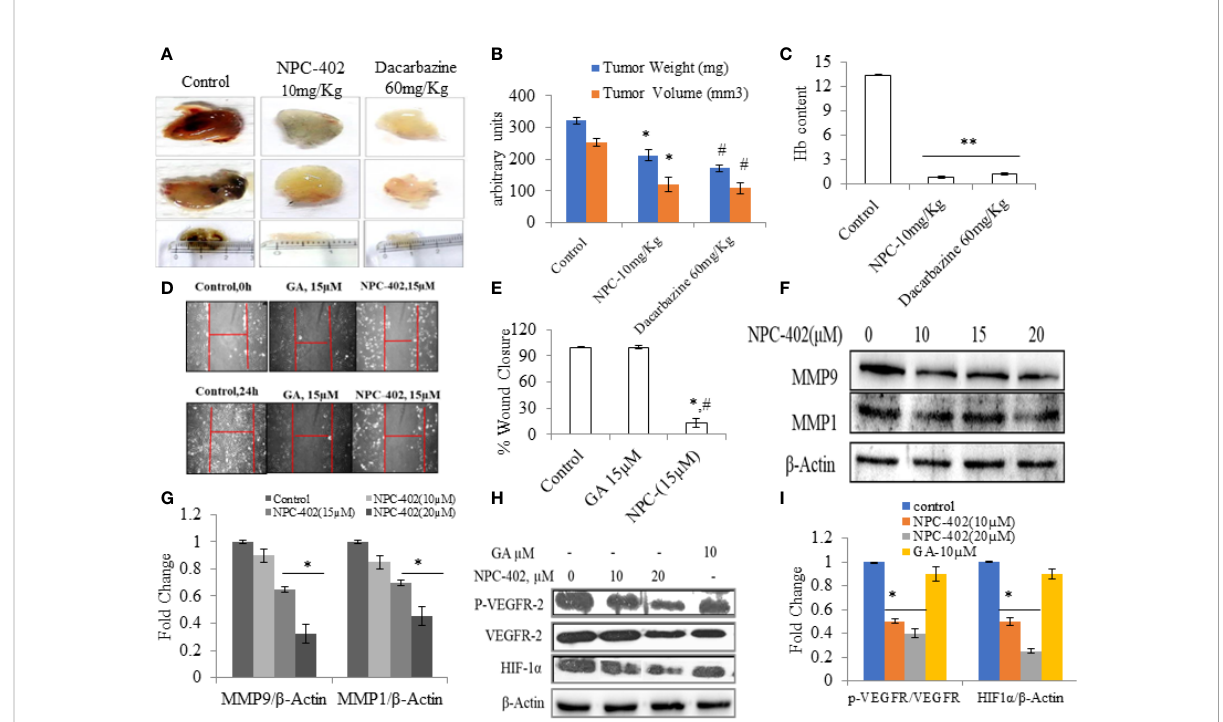
FIGURE 5 NPC-402 inhibits VEGF-mediated tumor angiogenesis in Matrigel assay. (A) Represents in vivo angiogenesis via Matrigel assay in C57BL/6J mice treated with/without NPC-402, and dacarbazine was used as a standard drug against melanoma. (B) Bar graph represents the tumor weight and volume of C57BL/6J mice treated with/without NPC-402 (* p < 0.001 control vs. NPC-402 group, # p < 0.001 control vs. dacarbazine group). (C) Bar graph represents Hb content of tumors, C57BL/6J mice treated with/without NPC-402 (* p < 0.001 control vs. NPC-402 group, # p < 0.001 control vs. dacarbazine group). (D) Images represent the cell migration assay ( in vitro ) in B16F10 cells treated with NPC-402. (E) Bar graphs describes the percentage wound closure in B16F10 cells treated with/without NPC or GA (* p < 0.001 control vs. NPC-402, # p < 0.001 GA vs. NPC-402). (F) Represents the Western blots of MMP1 and MMP9 in B16F10 cells treated with NPC-402 for 24-h. b -Actin was used as a loading control. (G) Bar graphs represent the densitometry analysis of MMP9 and MMP1 in B16F10 cells treated with NPC-402 for 24 h using